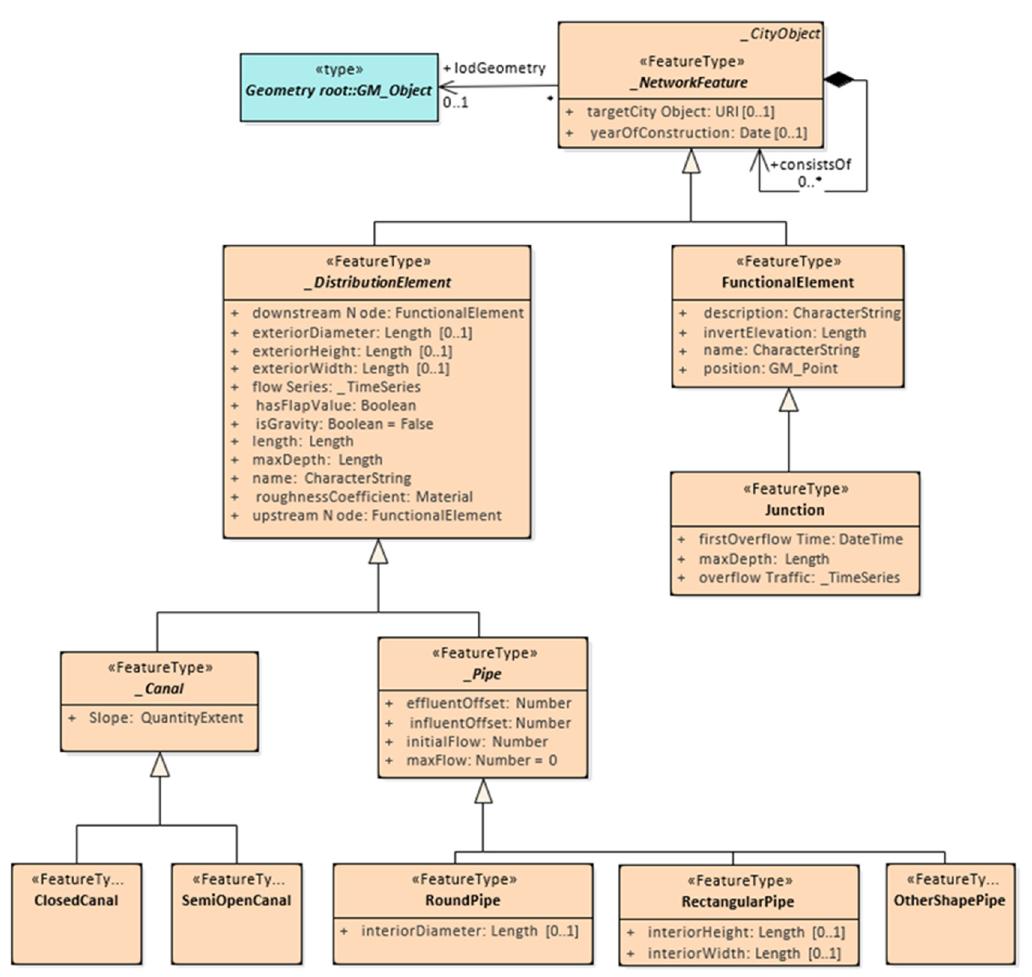
Figure 4. UML class diagram of NetworkFeature.